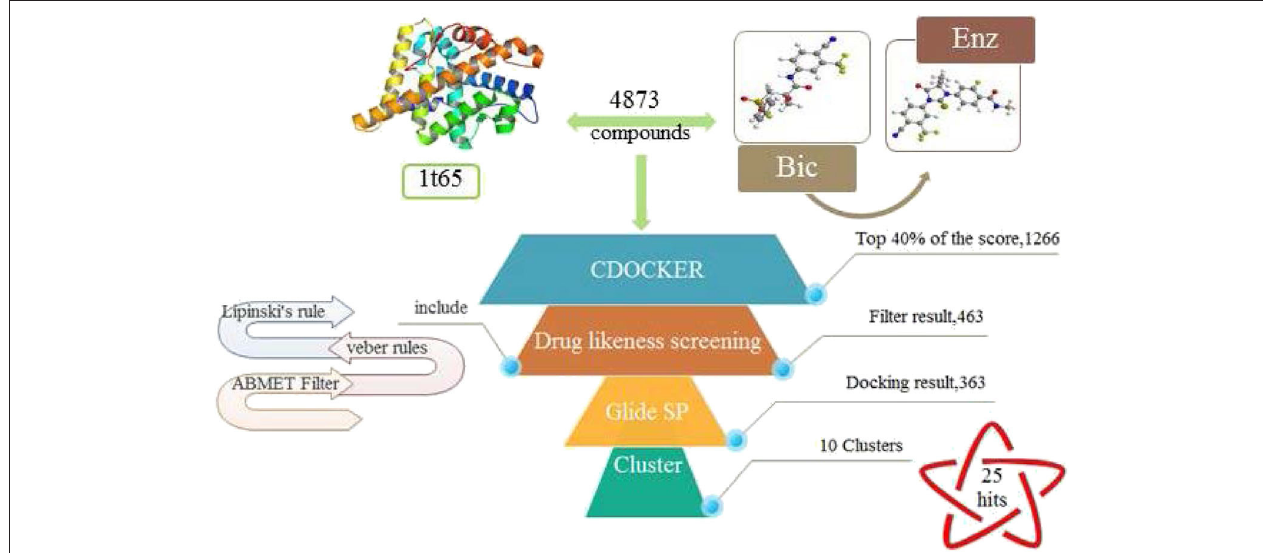
FIGURE 1 | Virtual screening protocol used in this